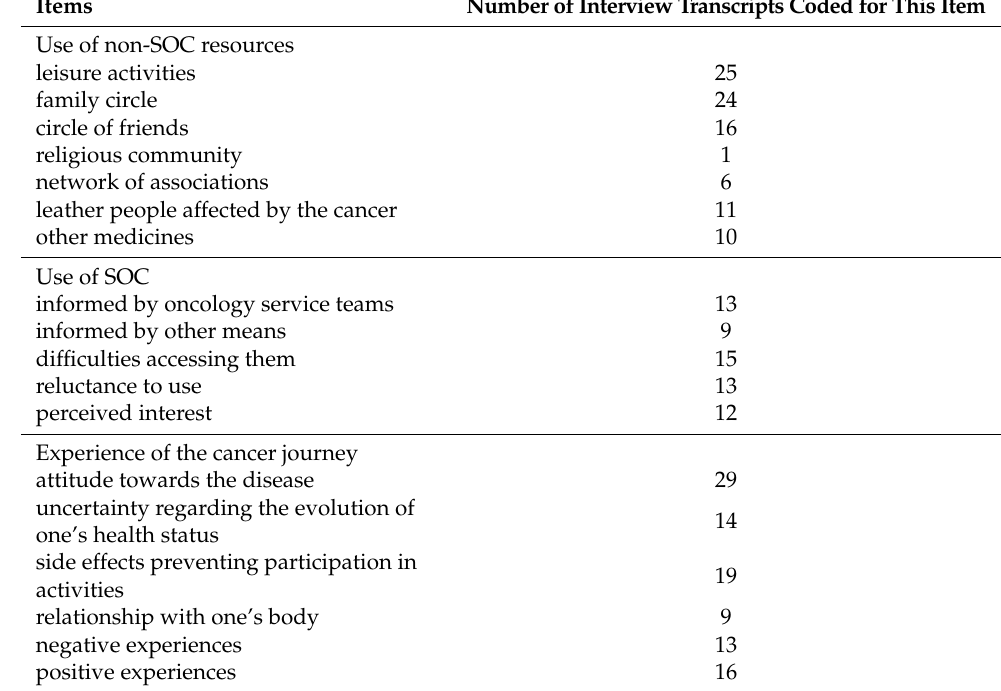
Table A1. Thematic analysis tree exported from NVivo© analysis